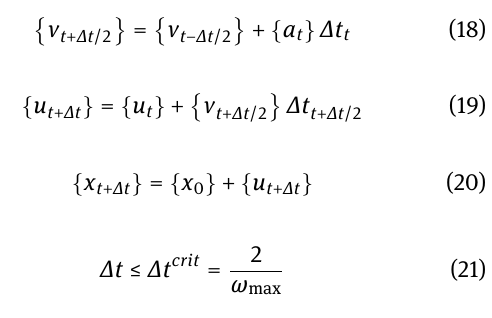
algorithm of FE codes ANSYS LS-DYNA [30], a scale factor of 0.9 is selected to decrease the time step and keep